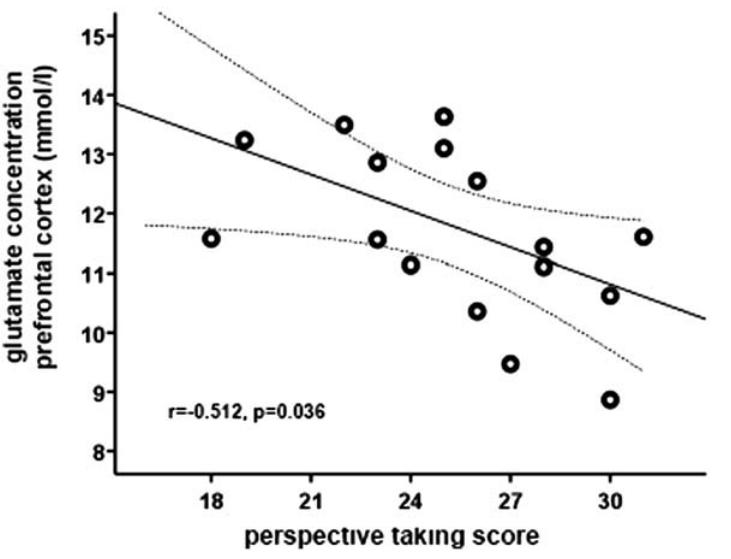
Figure 1. Correlation (Pearson) of prefrontal glutamate level and ‘‘perspective taking’’ score